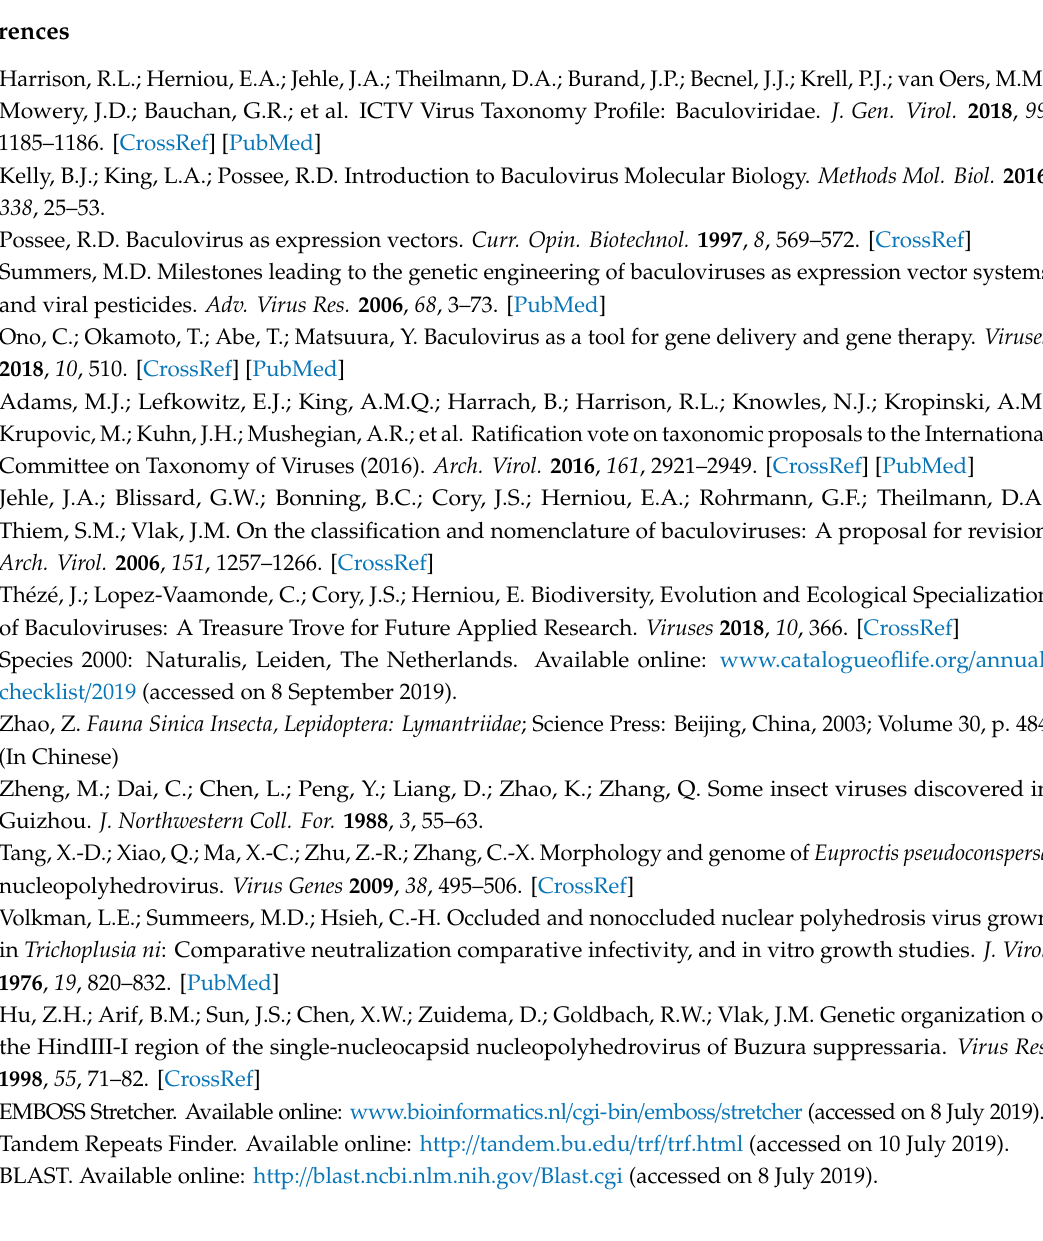
Table S1: genome annotation, Table S2: Basic information of all sequenced baculovirus genomes in GenBank, Table S3: core genes of 107